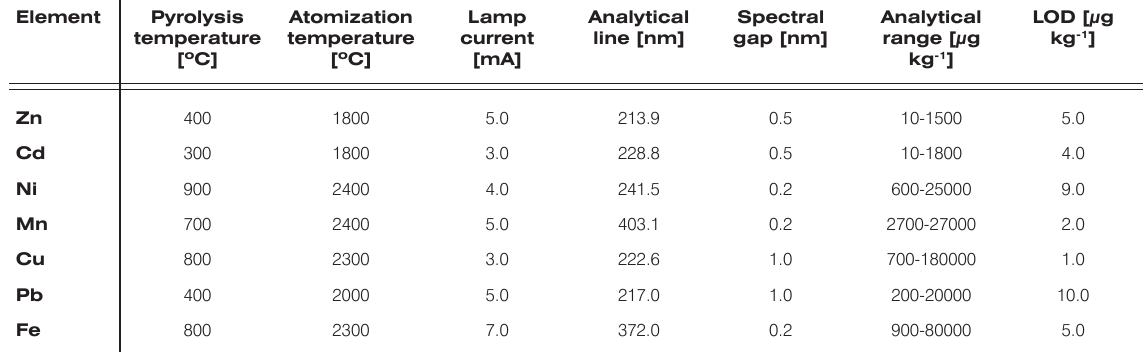
Table 1. Conditions of AAS analysis.